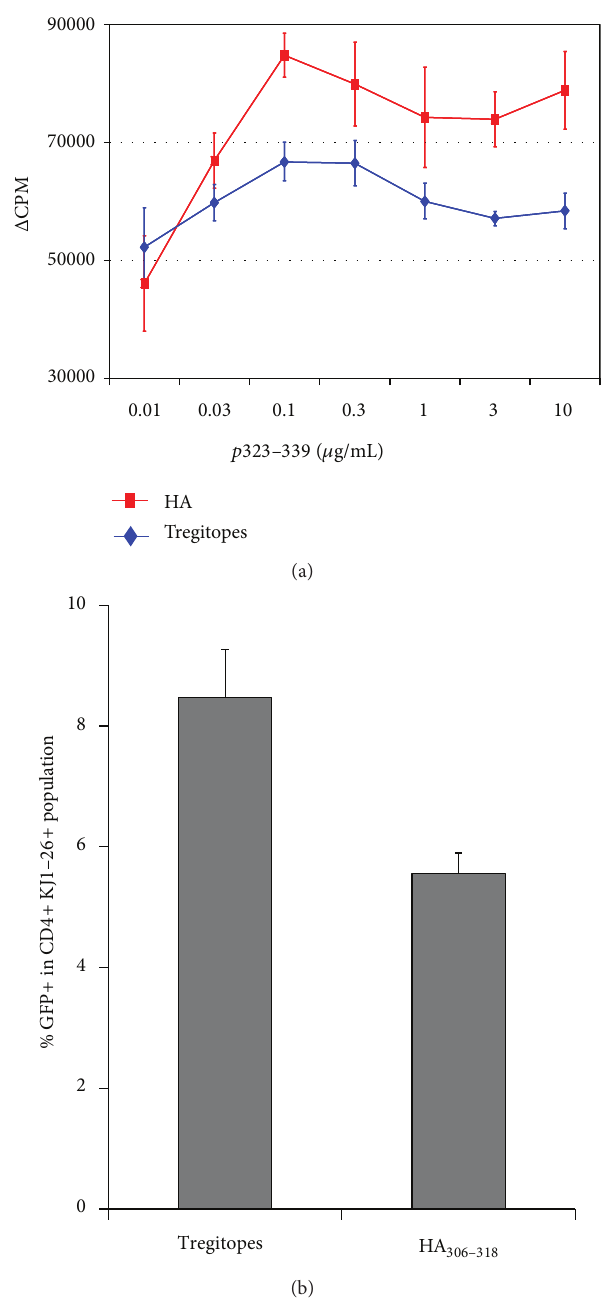
Figure 7: Tregitope effect in TCR-transgenic mice. DO11.10 FoxP3/ GFP transgenic mice were immunized with mT167/mT289/IFA and an irrelevant peptide HA (influenza hemagglutinin, Table 2) in IFA. After 10 days, mice were sacrificed and assayed for (a) T cell proliferation by in vitro culture with pOVA, and (b) FoxP3/GFP (Tregs) expression by FACS after CD4 and KJ1-26 staining. Gamma interferon expression in cell-culture supernatants was also sup- pressed (data not